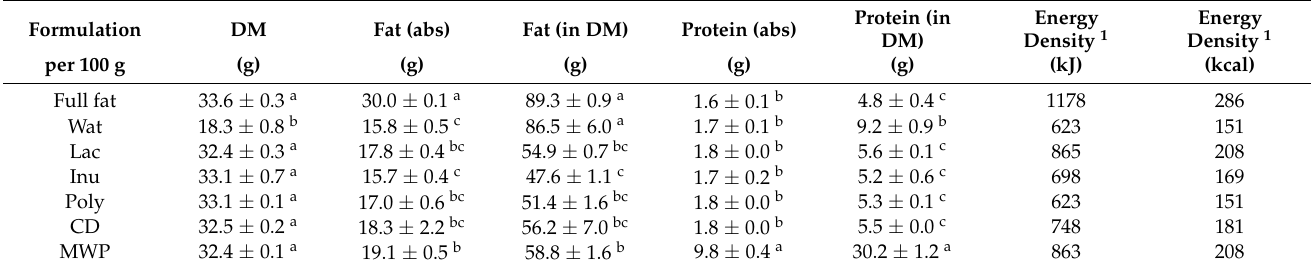
Table 4. The pH values of the samples were around pH 5.9 with no significant difference between them; only the sample with MWP had a significantly higher pH value with pH 6.4. Table 4. Composition of the samples based on 100 g emulsion (abs = absolute, DM = dry matter, Lac = lactose, Inu = inulin, Poly = polydextrose, CD = corn dextrin, MWP = microparticulated whey protein).